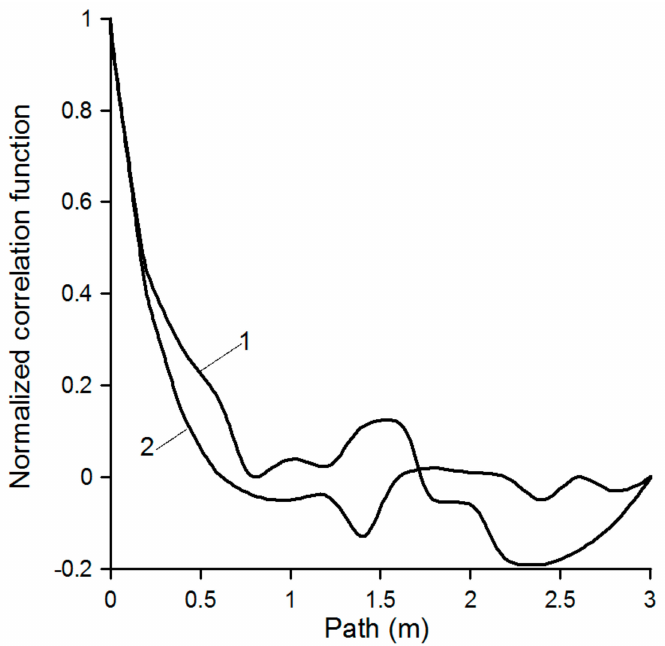
Figure 9. Normalized correlation functions of the surface’s longitudinal profile (1) and plowing depth (2) oscillations.